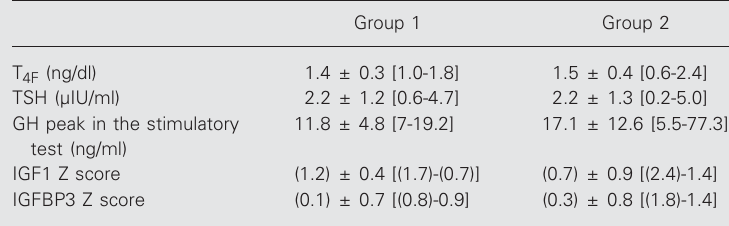
Table 2. Hormonal measurements of patients with short stature and active or poten- tial celiac disease (group 1) and patients with short stature of undetermined cause (group 2).